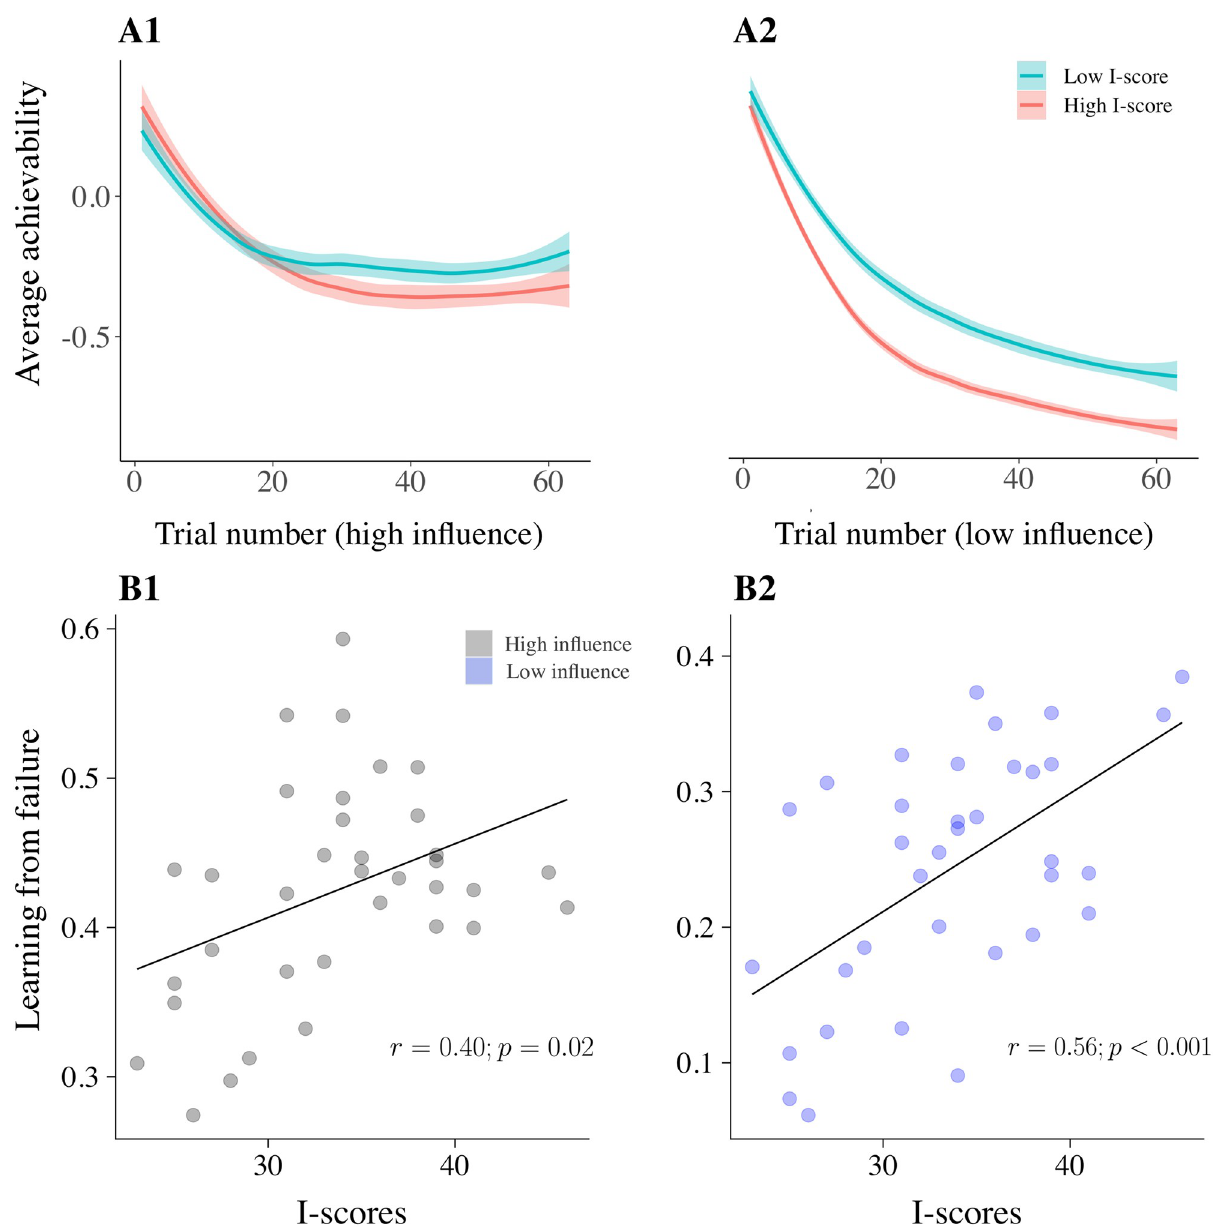
Fig 6. Learning from failure and the evolution of achievability. Plots A1 and A2 illustrate the evolution of average achievability (i.e. the parameter H t ) through DGTs in high and low influence conditions respectively. This is the average achievability because we consider the average of the values of H the two vehicles at each trial. The shaded error bands reflect standard error across subjects. The x -axis reports the ordered trials for each condition. This is a total of 64 trials (as there are 16, times 4, DGTs per each condition). For illustration purposes, we divided our subjects into two groups using a median split on I-scores. We can observe the average achievability learnt through Rescorla-Wagner updates decrease faster for high I-scorers in both influence conditions, however, the difference across the two groups is most apparent in low influence conditions. Plots B1 and B2 illustrate the correlations between I-scores and learning from failure in high and low influence conditions respectively, which underpin the temporal evolution of H t shown in A1 and A2. The effect is stronger in low influence conditions—however, note that the � l parameter in these conditions exhibits a measure of confusion, particularly with the initialisation (i.e. H 1 ) parameter (see S5